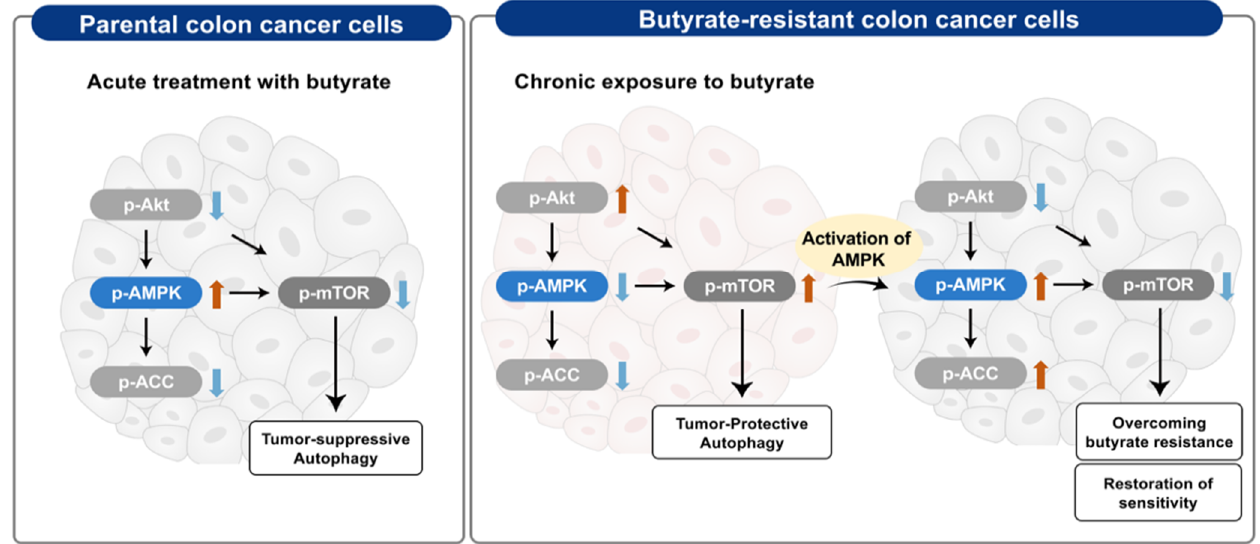
Figure 8. Summary of possible mechanisms in parental (PT) and butyrate-resistant (BR) colon cancer cells. p-, phospho-.